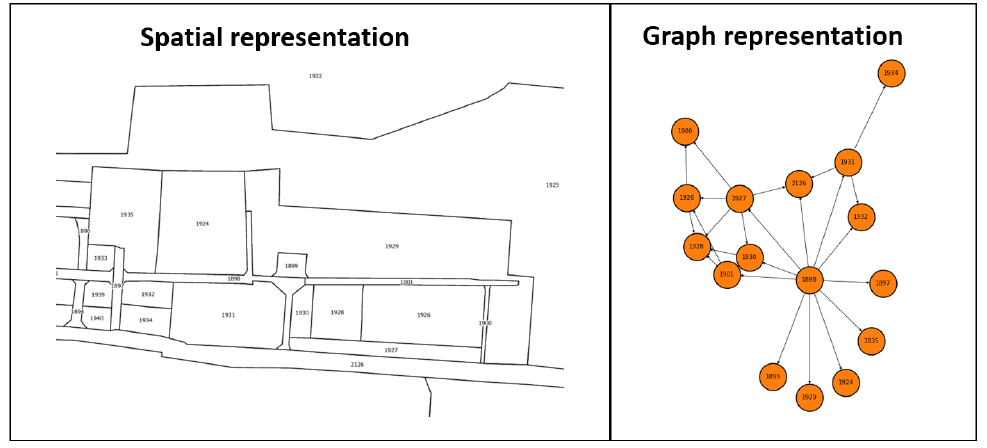
Figure 4. Spatial and graph representation of spatial